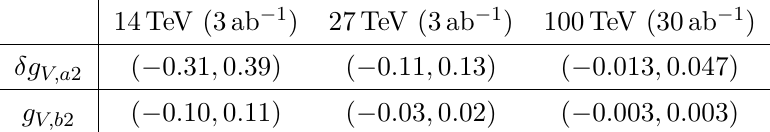
Table 14 . 5 σ discovery (excess) bounds of g V,a 2 and g V,b 2 at a 14 TeV, 27 TeV and 100 TeV hadron collider, assuming the respective total integrated luminosity in